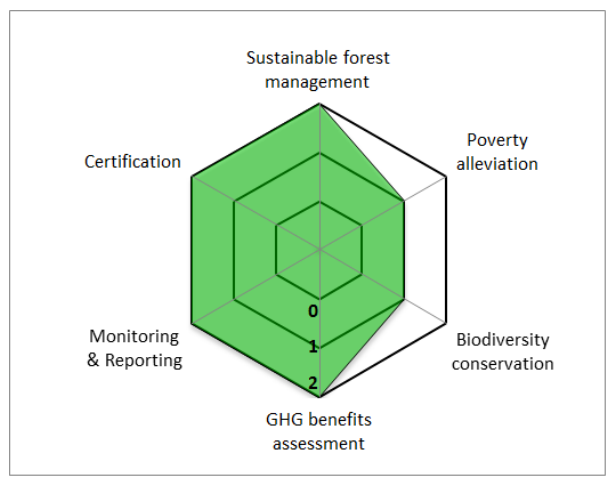
Figure 6. Summary of CarbonFix